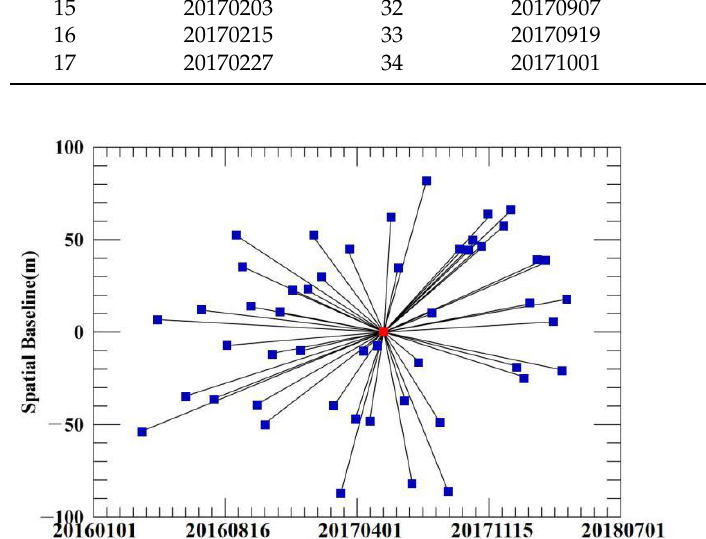
Figure 3. Distribution of the temporal and spatial baselines. The red square indicates the reference image; blue squares indicate the slave images.